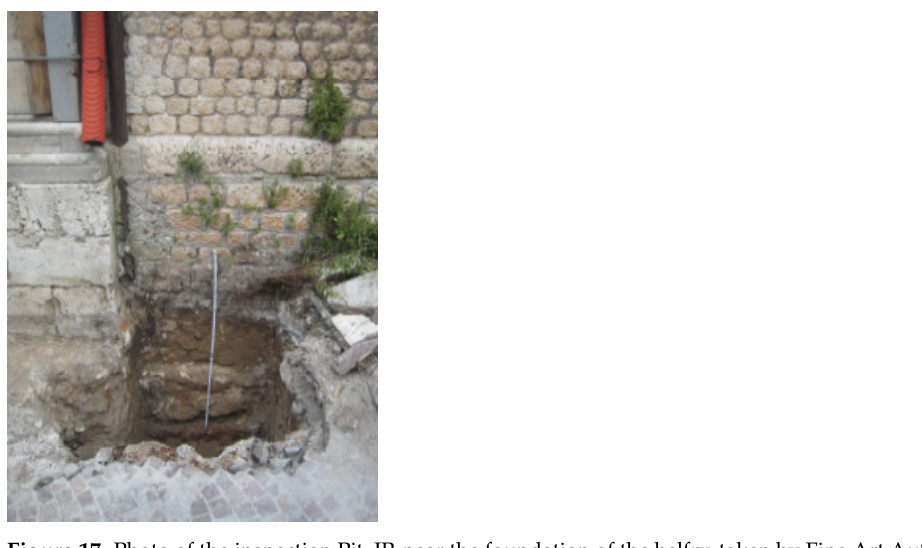
Figure 17. Photo of the inspection Pit, IP, near the foundation of the belfry, taken by Fine Art